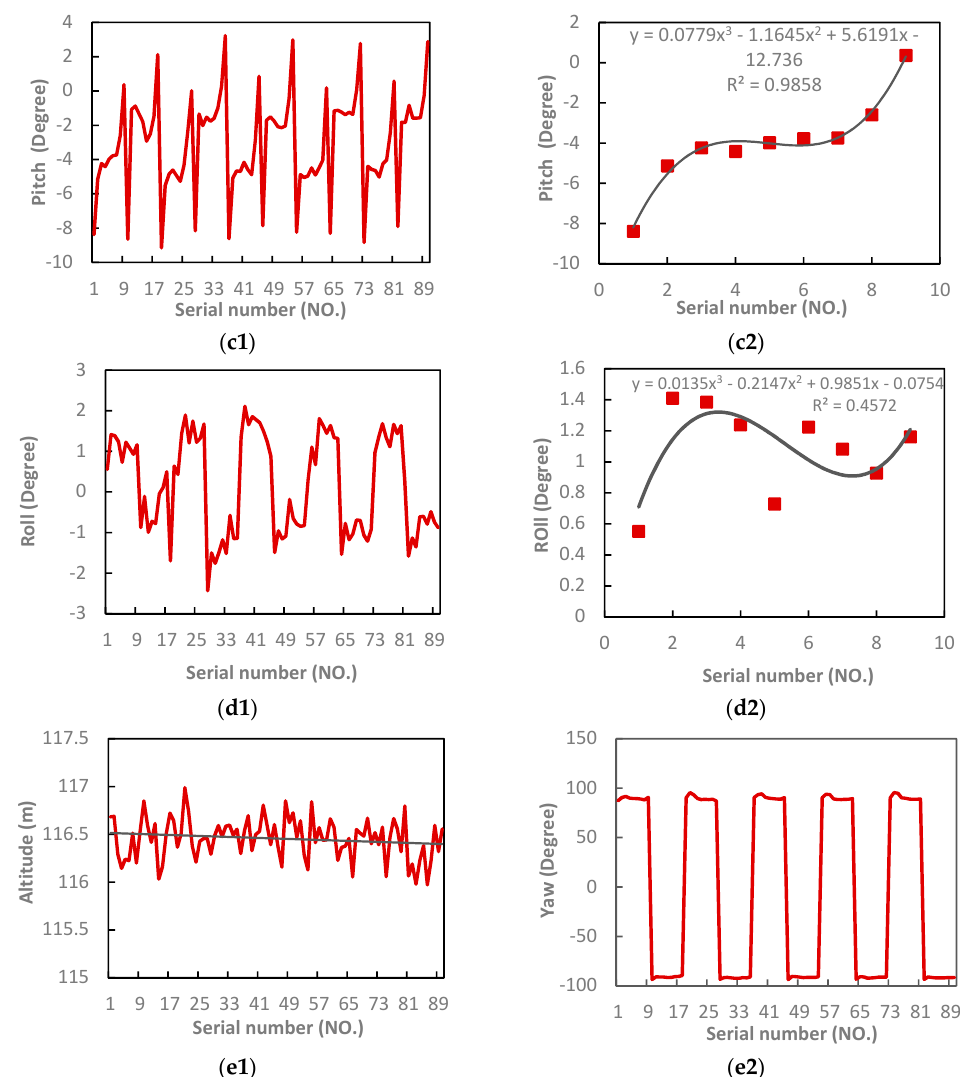
Figure 8 . ( a1 ) Longitude of all flight strips; ( a2 ) linear fit of longitude for first flight strip; ( b1 ) latitude of all flight strips; ( b2 ) linear fit of latitude for first flight strip; ( c1 ) pitch of all flight strips; ( c2 ) linear fit of pitch for first flight strip; ( d1 ) roll of all flight strips; ( d2 ) linear fit of roll for first flight strip; ( e1 ) trajectory of flight altitude; ( e2 ) trajectory of flight yaw (the serial number refers to the numerical order of the photos).